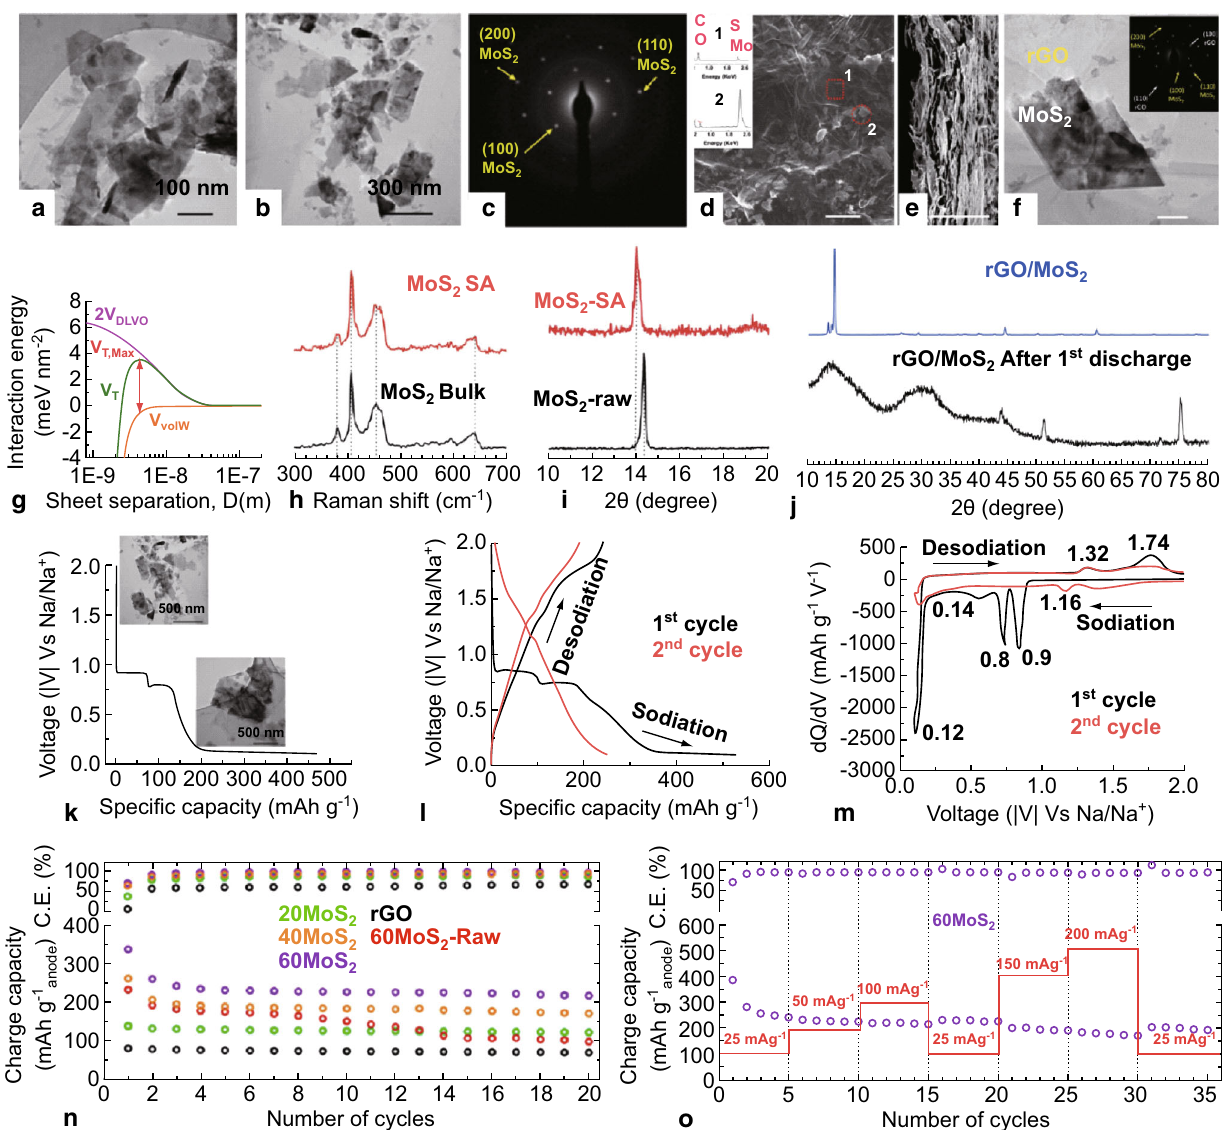
Fig. 5 Structural characterization and electrochemical performance analysis of TMD (MoS 2 ) as an electrode material in SIB: a , b HRTEM images of exfoliated MoS 2 nanosheets obtained after treatment with a superacid. c Selected area diffraction pattern for the MoS 2 nanosheet imaged in Fig. b . d , e SEM images of the top and cross-sectional view of the 60 MoS 2 sample (60 wt% MoS 2 -40 wt% rGO), respectively. e TEM image of SAED pattern (in the inset) of the same 60 MoS 2 sample. g Graphical representation of the total interaction potential (VT), repulsion ( V DLVO ), and attraction energy ( V vdW ) versus greater sheet separation. h Raman spectra of the MoS 2 samples, in bulk (black) and after exfoliation (red) by acid treatment. i XRD spectra of the bulk (black) and exfoliated MoS 2 (red) sample, indicating the peak shift and the broadening of the consequent increase in the interlayer distance of the exfoliated sample. j XRD pattern of pristine MoS 2 -rGO (60 MoS 2 ) electrode (blue) and the same after one discharge cycle (black). Considerable peak broadening is observed due to sodiation. k First discharge graph of the 60 MoS 2 electrode, also showing the formation of nanocrsytallites along the process from the TEM images and SAED patterns in the inset. l 1st (black)- and 2nd-cycle (red) GCD curves for the 60 MoS2 sample. m Differential capacity curves for the first two cycles demonstrating the redox voltages. n Charging capacity and Coulombic efficiency values for the different composite and bare rGO sample performed at a current density of 25 mA g - 1 . o Charge capacity, coulombic efficiency, and rate capability of 60 MoS 2 sample [83]. Copyright 2014 American Chemical Society. Scale bar for d , e is 10 l m and for f is 100 nm. (Color figure